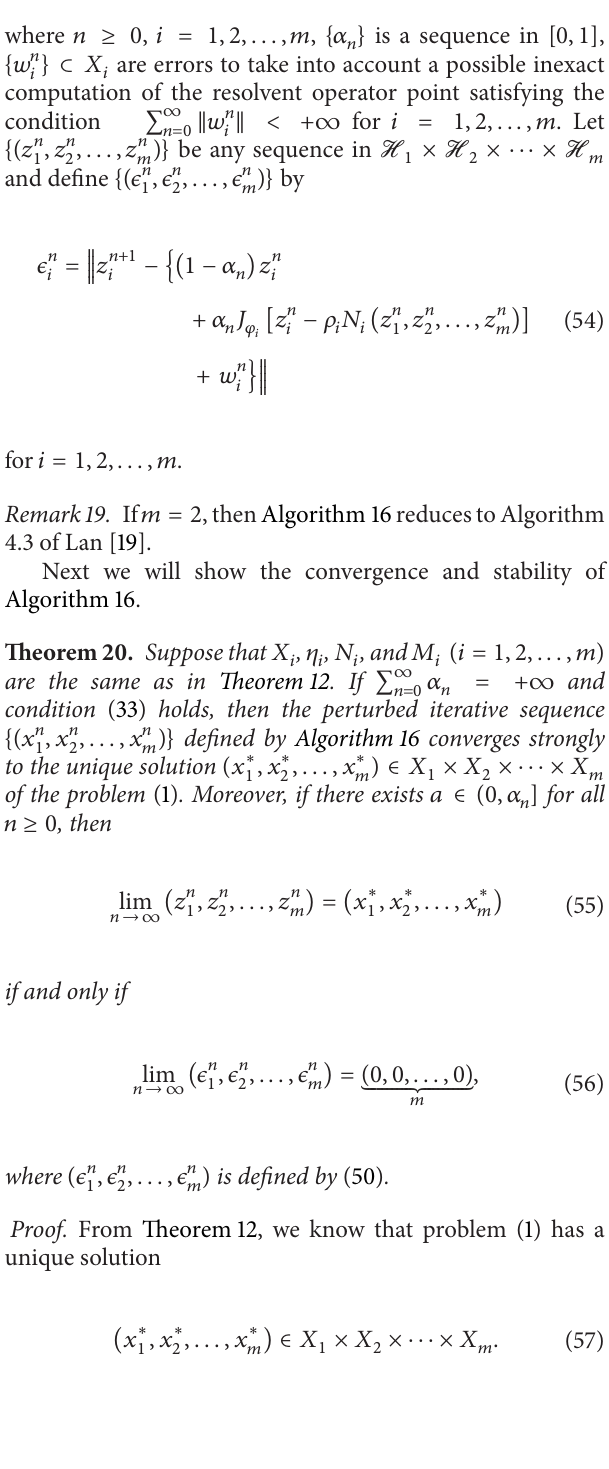
Algorithm 18. Let 𝑁 𝑖 : H 1 × H 2 × ⋅ ⋅ ⋅ × H 𝑚 → H 𝑖 be single-valued mappings and 𝜑 𝑖 : H 𝑖 → (−∞, +∞] is proper, convex, and lower semi-continuous functional on H 𝑖 for 𝑖 = 1, 2, . . . , 𝑚 . For any given initial point (𝑥 0